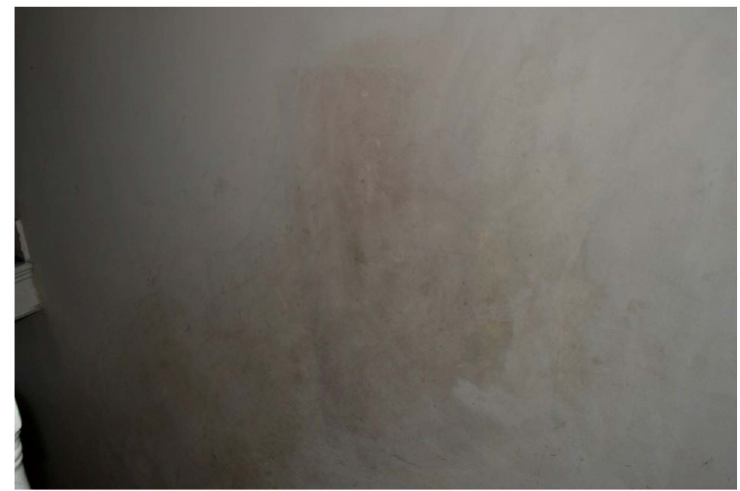
Figure 5. House visit where Participant.Survey11 reported “Damp a wall” [sic].